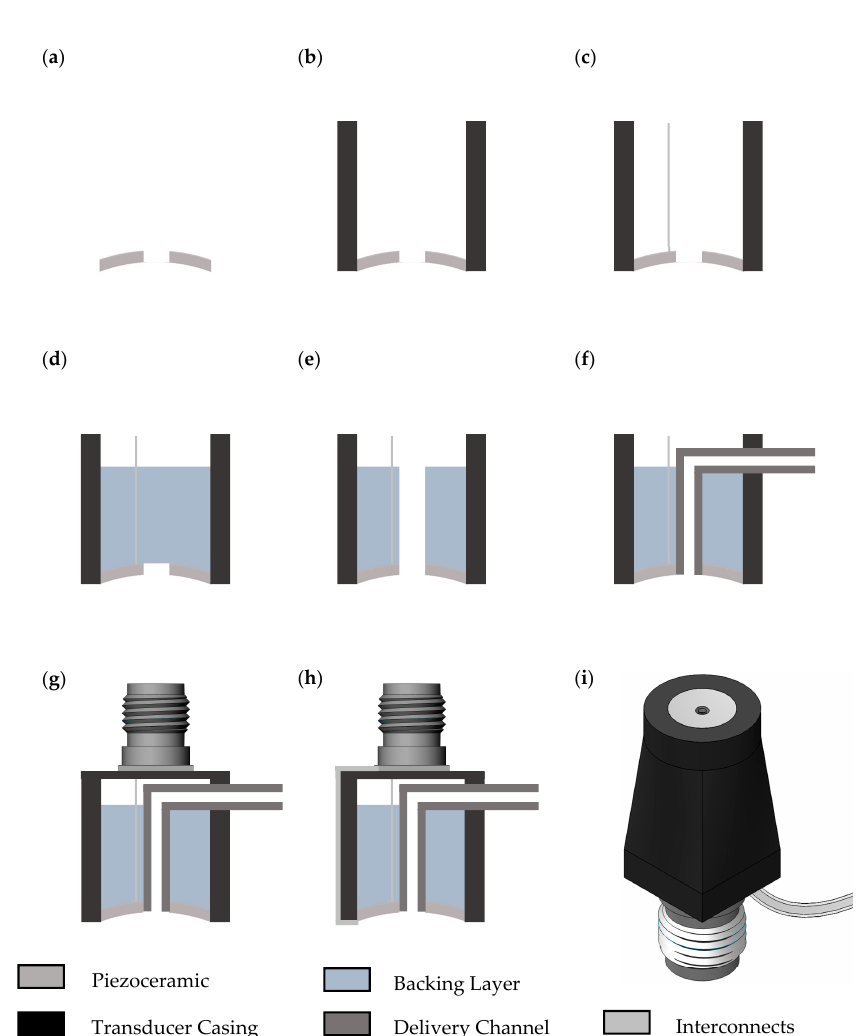
Figure 8. ( a ) Piezoceramic material was placed face down on a flat glass surface. ( b ) An additively- manufactured casing was placed over the piezoceramic material, ensuring they were